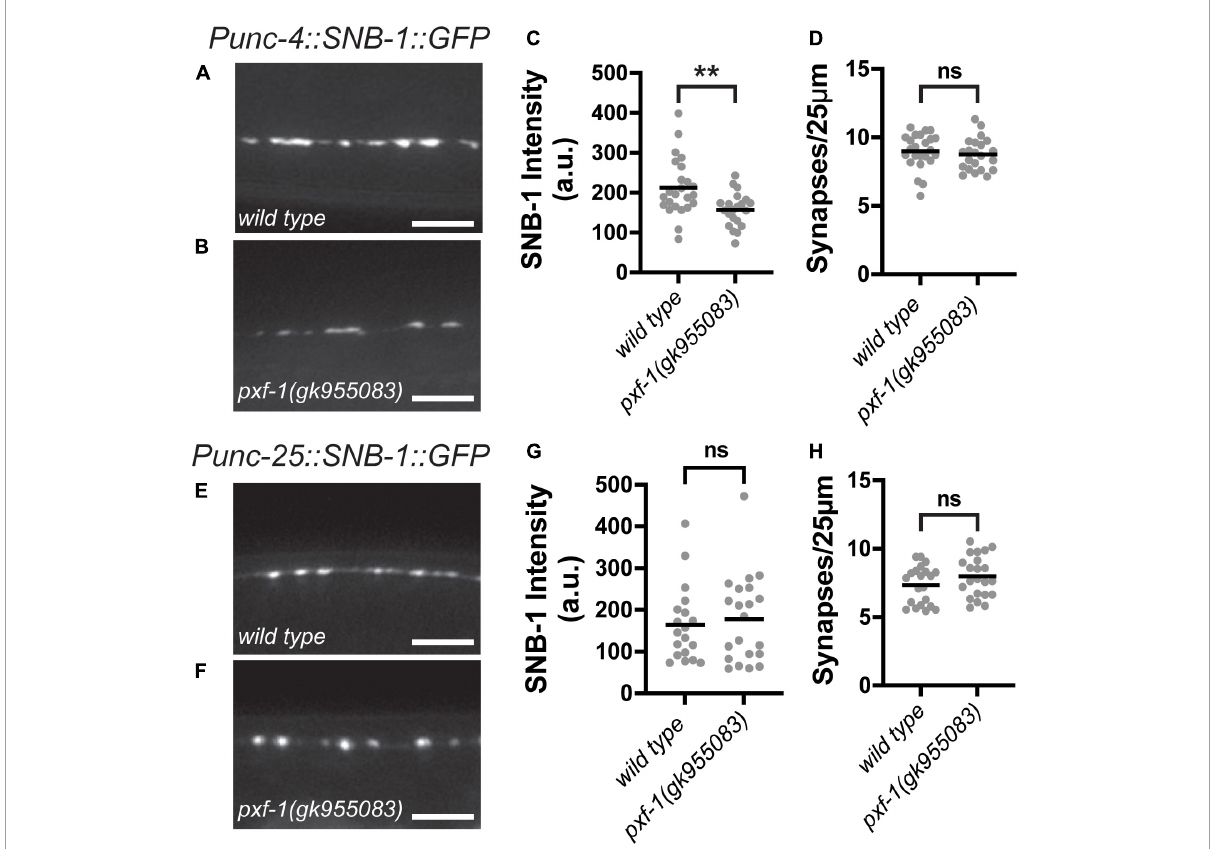
FIGURE4 Synaptic vesicle abundance in GABAergic neurons is normal in pxf-1 mutants. (A,B) Representative images of SNB-1:GFP labeled acetylcholine synapses in SAB neurons of (A) wild type and (B) pxf-1(gk955083) animals. Scale bars are 5 µ m. (C) Quantification of fluorescence intensity in arbitrary units, a.u. (D) Quantification of synaptic density. Gray dots represent individual animals, black bars indicate means. n = 21–24 animals. ** p < 0.01; ns, not significant. (E,F) Representative images of SNB-1:GFP labeled GABA synapses in dorsal cord of (E) wild type and